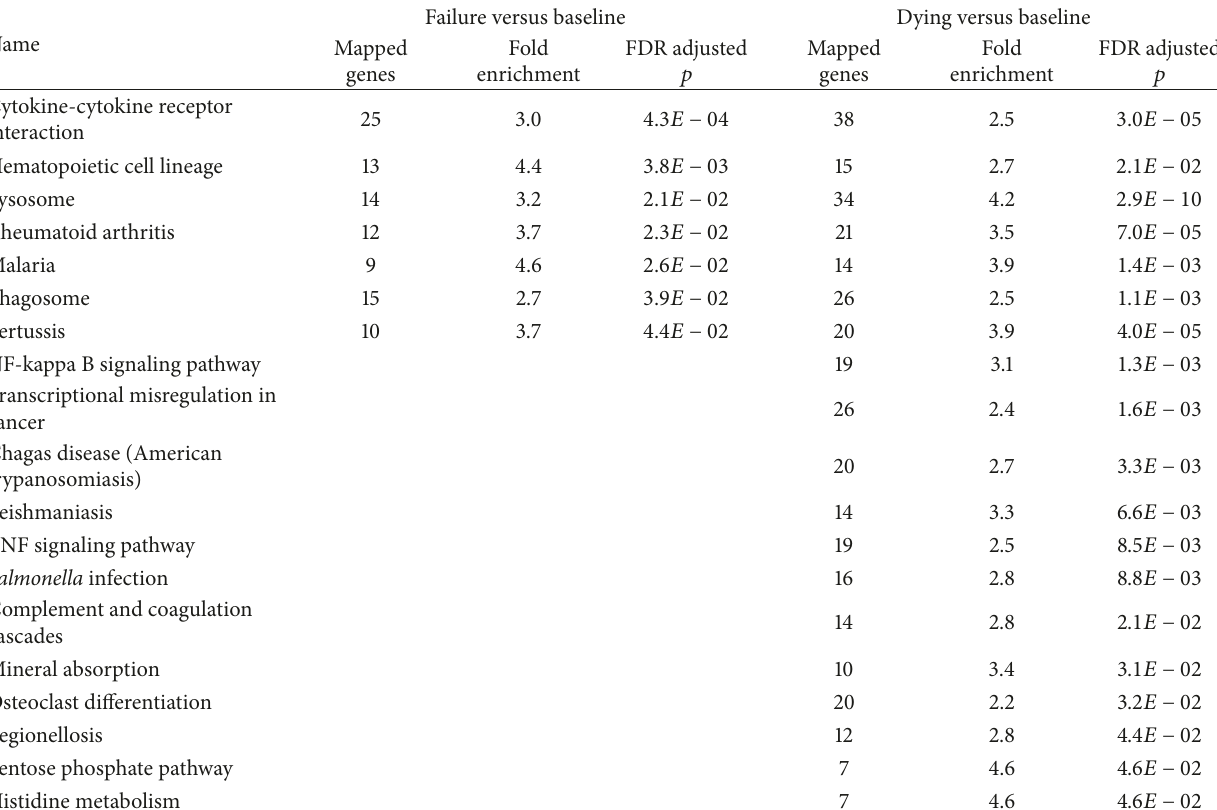
Table 3: KEGG pathways involved in the progression of ALF.